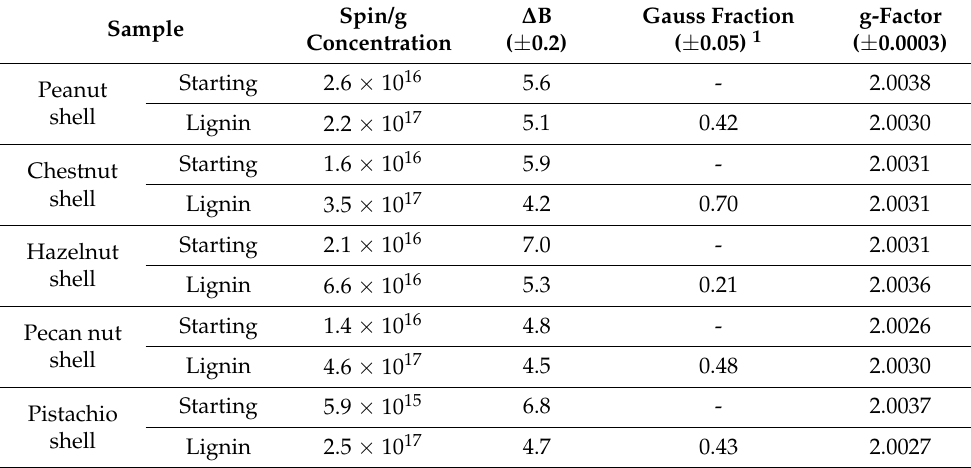
Table 2. EPR data for nut shells and related